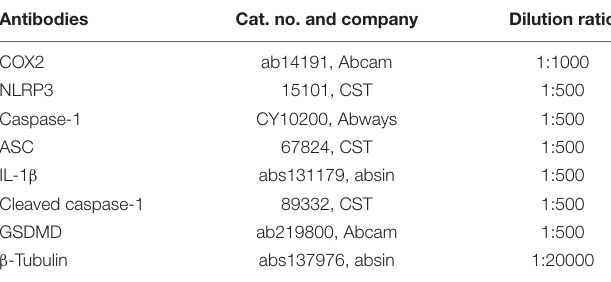
TABLE 1 | Antibodies applied in Western blotting.